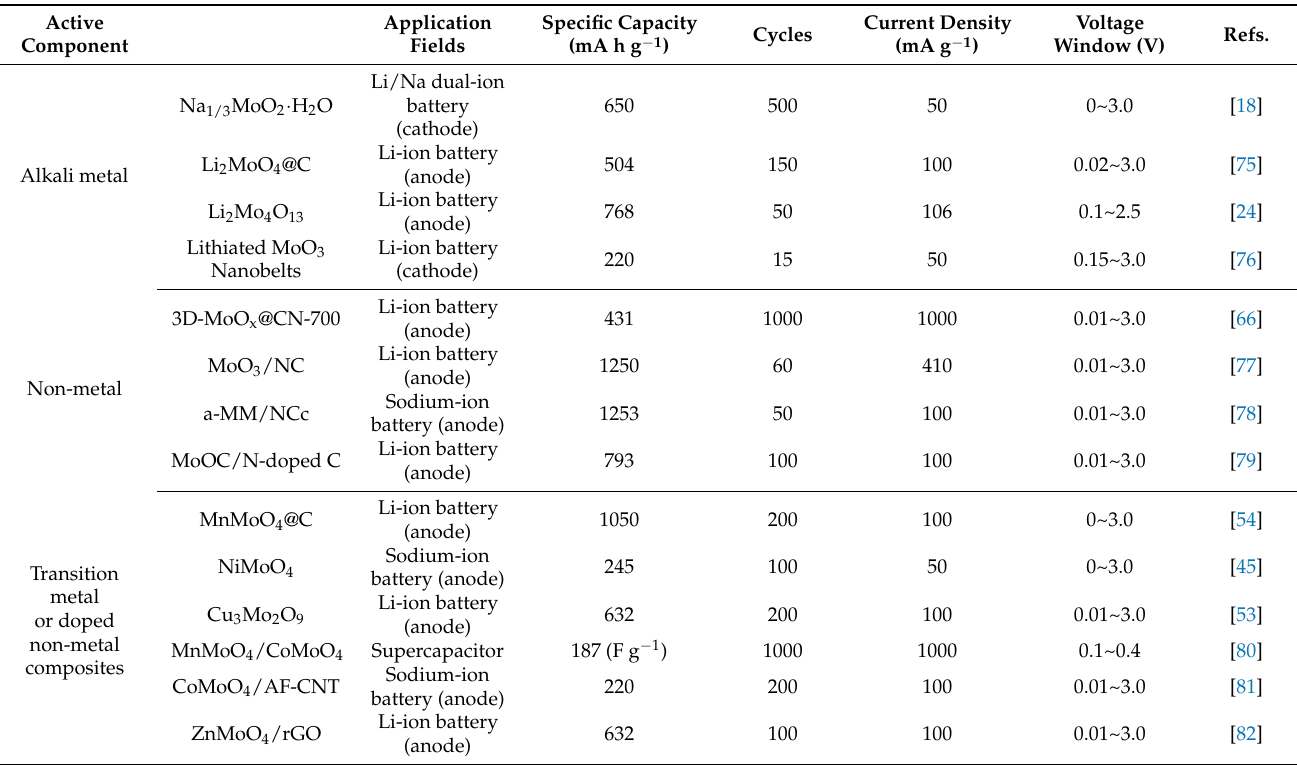
Table 1. Summary of the properties and applications of some hetero-element-doped molybdenum oxide materials. Active